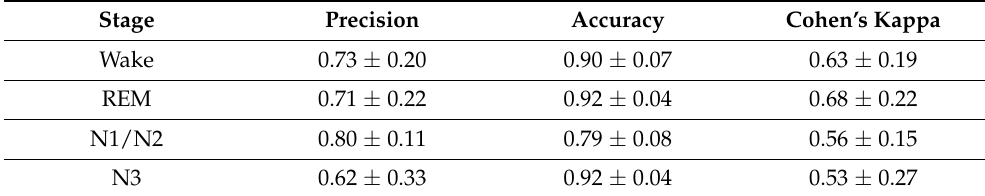
Table 4. Summarizing table with the performance of the sleep stage classification algorithm presented in